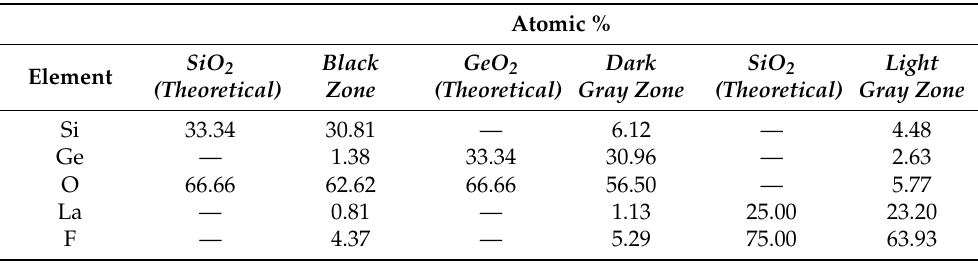
Table 3. Theoretical and average atomic percentages obtained by EDX of the different elements constituting the three studied compounds before thermal